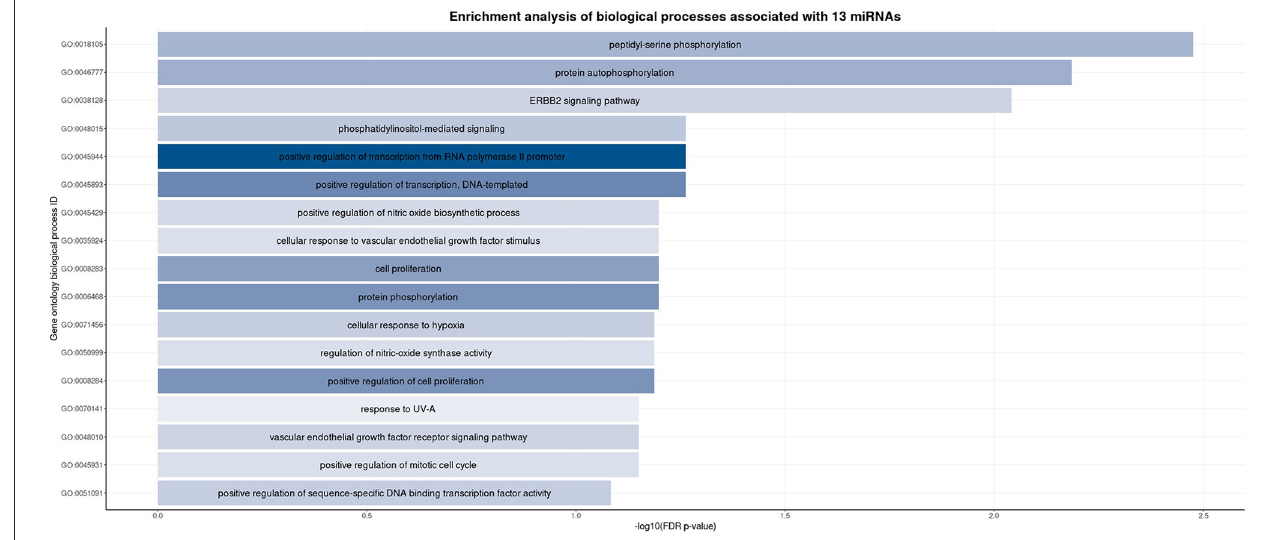
FIGURE 3 | Enrichment analysis of the biological processes associated with our miRNA gene target list at three different timepoints post-injury. We used the DAVID database to upload a list of target genes based on the miRNAs found to be significantly associated with PPCS in our cohort. This figure presents the biological processes found to be significantly associated (false discovery rate p -value < 0.10). Each bar represents a biological process ID, whose gene ontology ID and corresponding description are listed. The width of each bar represents the –log10(FDR p -value) while the color of each bar indicates the count (number) of our target genes associated with that particular biological